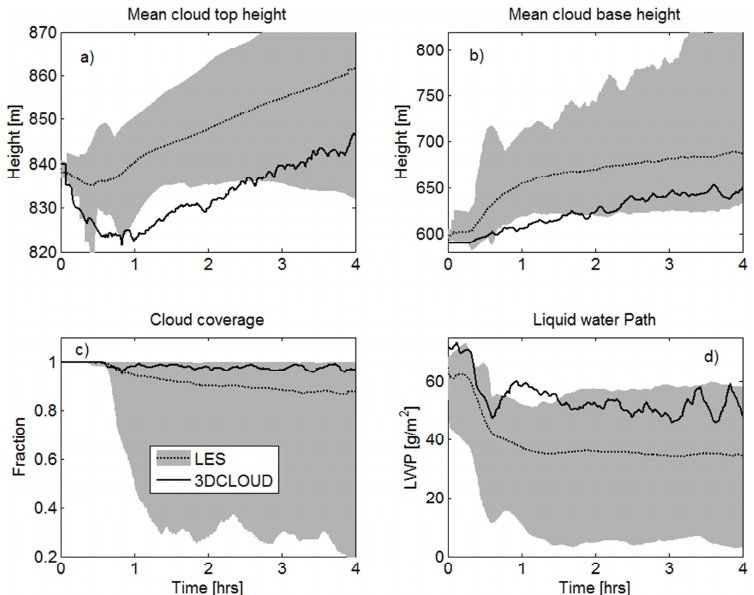
Figure 2. Time series of (a) the mean cloud top height, (b) the mean cloud base height, (c) the cloud coverage, and (d) the liquid water path. The DYCOM2-RF01 case is displayed.The solid lines indicate 3DCLOUD results. The dotted lines indicate a mean over all LES results. The light shading around this mean delimits the maximum and minimum values within the master ensemble at any given time.